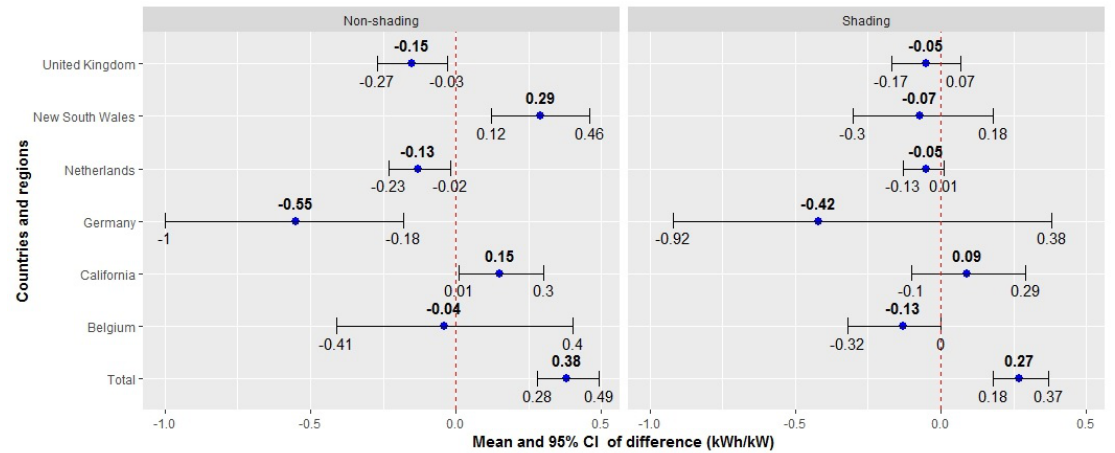
Figure 5. Comparative results of the differences in lifetime energy yield ( Y L ) between the PVs that use a micro-inverter configuration and PVs that use string inverter using bootstrap technique (Algorithm